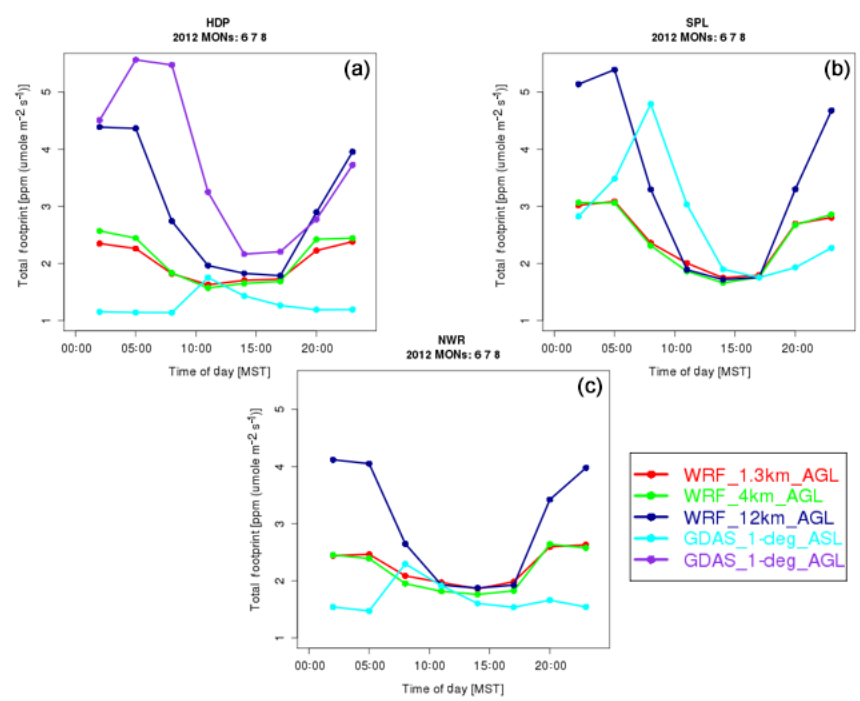
Figure 4. The average diurnal footprint strengths at HDP, SPL, and NWR over June–August 2012 from STILT, driven with different meteo- rological fields and release heights (ASL vs. AGL). The footprint strength was derived by summing over the spatial distribution of footprint values (Fig.